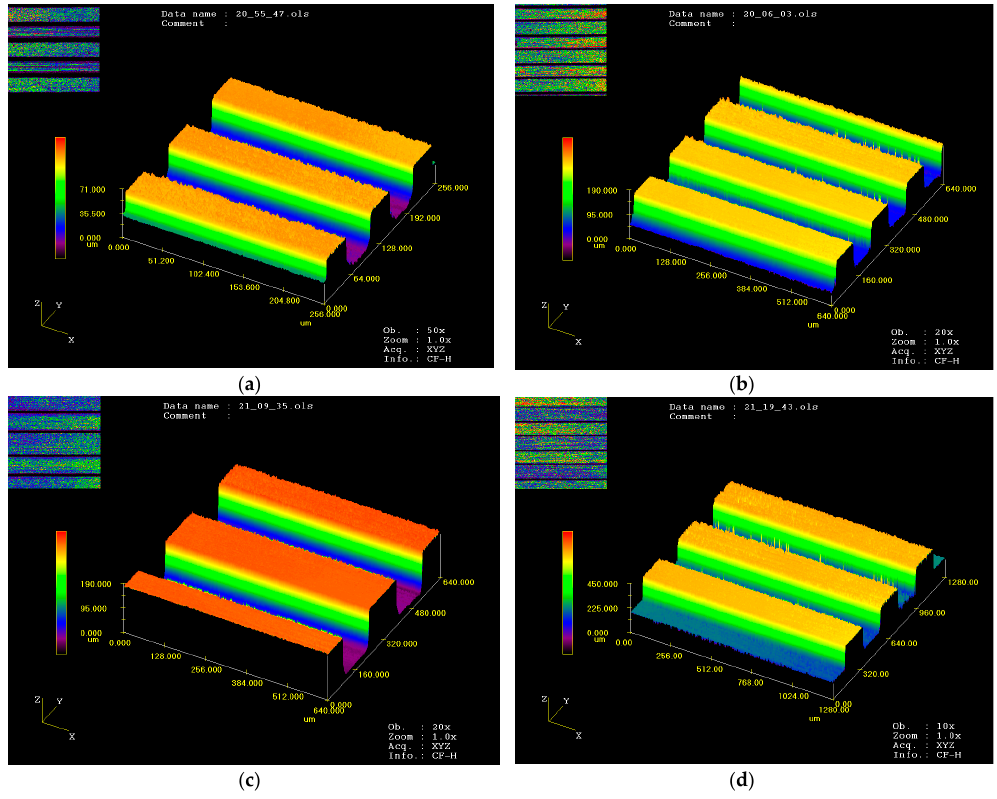
Figure 3. Profile measurements of micro-array channels dies with different widths: ( a ) 50 µ m; ( b ) 100 µ m; ( c ) 150 µ m; ( d ) 200 µ